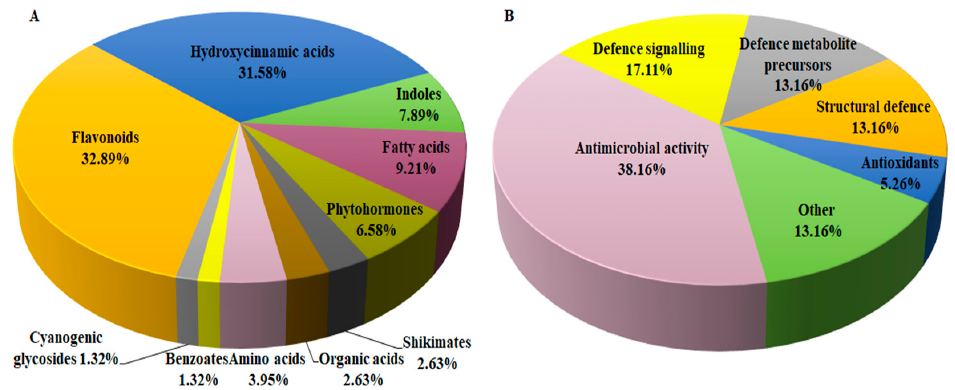
Figure 4. Classification of the annotated signatory/discriminatory metabolites in extracts of sorghum plants responding to infection by B. andropogonis , according to the chemical classes ( A ; see Table 1) and primary/prominent functions in defence ( B ; see Sections 3.1–3.4 for functions of some annotated metabolites). A total of 76 plant metabolites were putatively identified. ( A ): Illustrates the chemical diversity of metabolites potentially contributing to defence against B. andropogonis (flavonoids and hydroxycinnamic acids—two major classes). ( B ): Due to some metabolites possessing more than one function, grouping was based on the known primary/prominent role in plant defence.